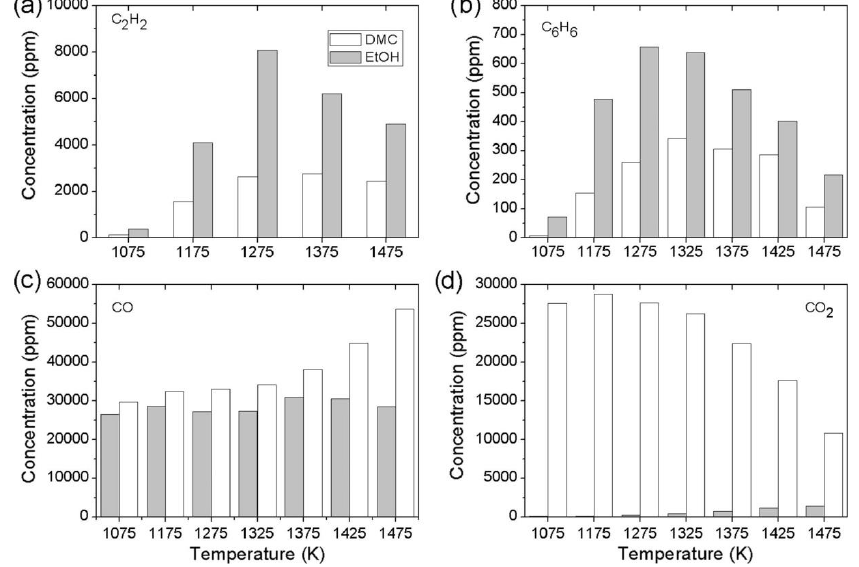
Figure 8. Concentrations of ( a ) acetylene ( C 2 H 2 ), ( b ) benzene ( C 6 H 6 ), ( c ) carbon monoxide ( CO ), and ( d ) carbon dioxide ( CO 2 ) produced by pyrolysis process of DMC and ethanol at different temperatures (1075–1475 K)